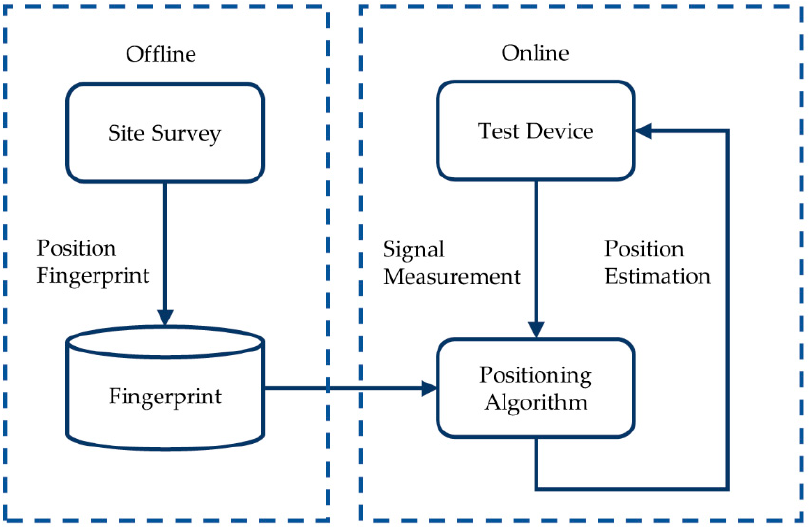
Figure 1. Flowchart of fingerprint positioning algorithm .